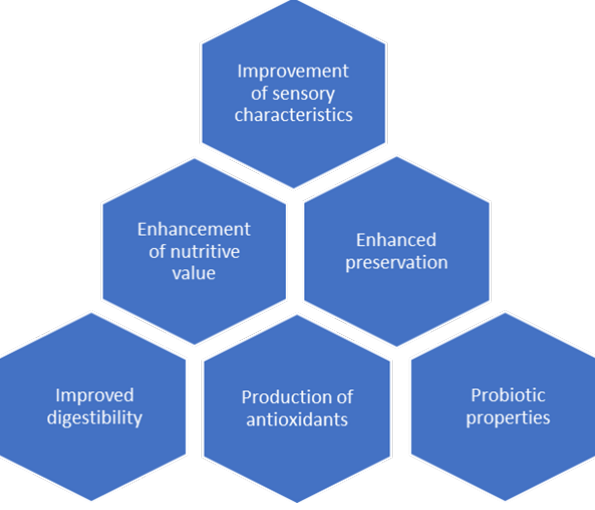
Figure 2. Functions associated with fermented milk products.